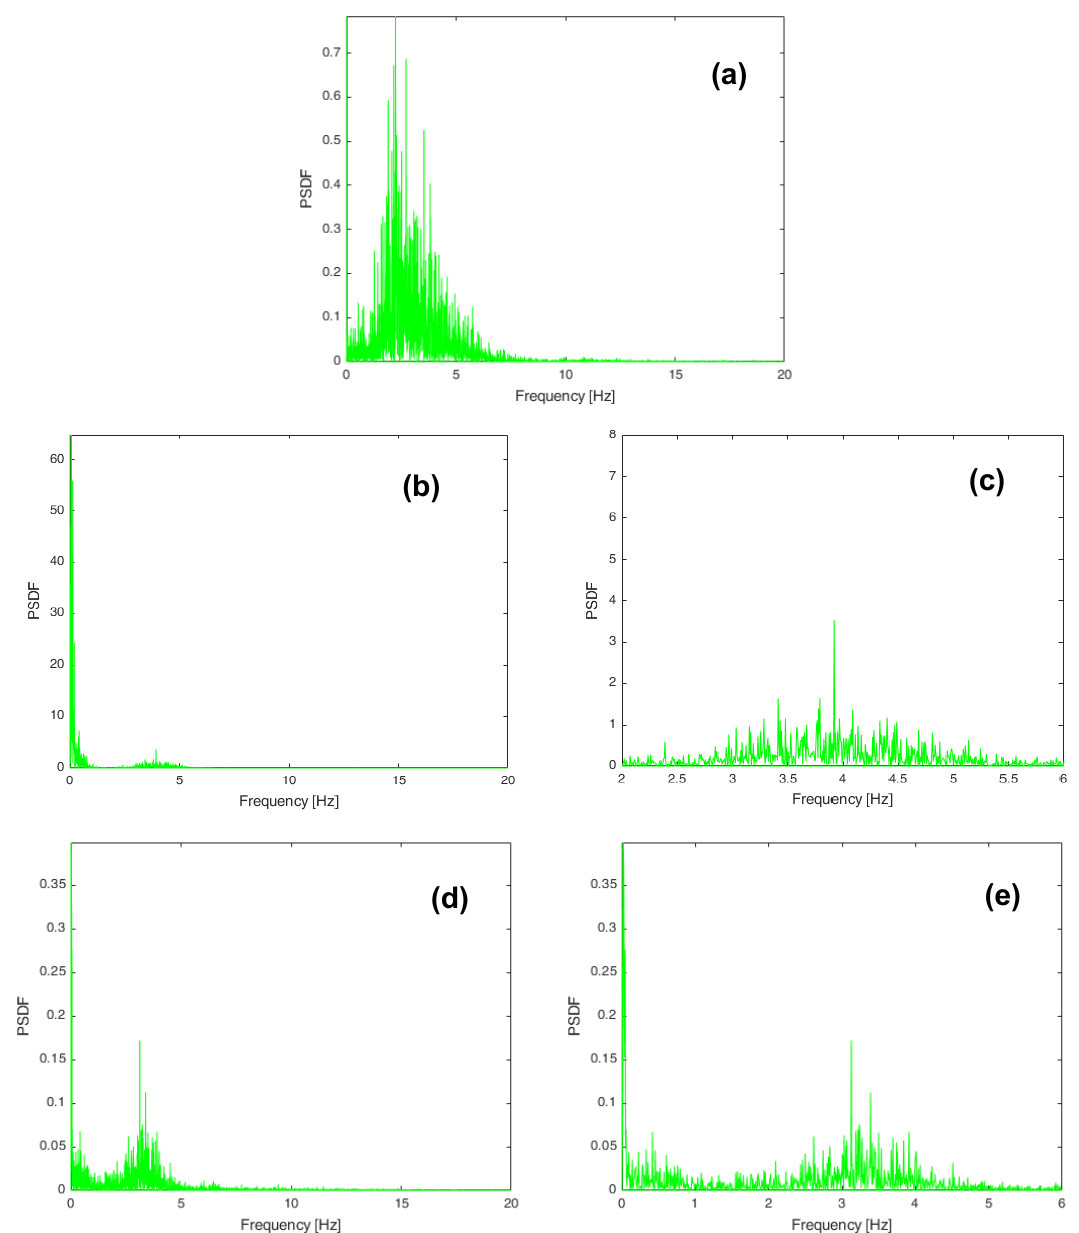
Figure 7. Power spectral density function (PSDF) of pressure fluctuations signals from test #1: pre-heating under N 2 , T = 767 °C ( a ); gasification ( b ) with magnification of a 2–6 Hz range ( c ); and post-combustion ( d ) with magnification of a 0–6 Hz range ( e ) .